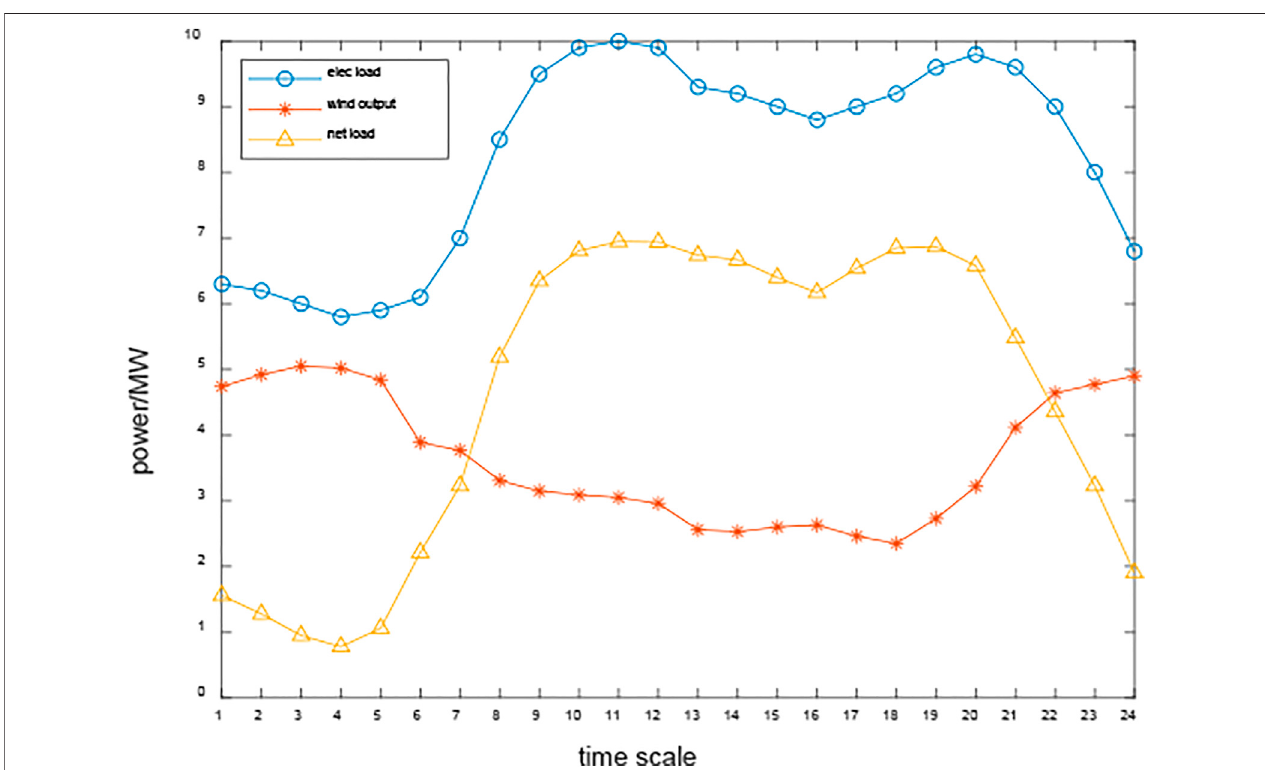
FIGURE 9 | Power demand load, wind power, and the net load of the system.